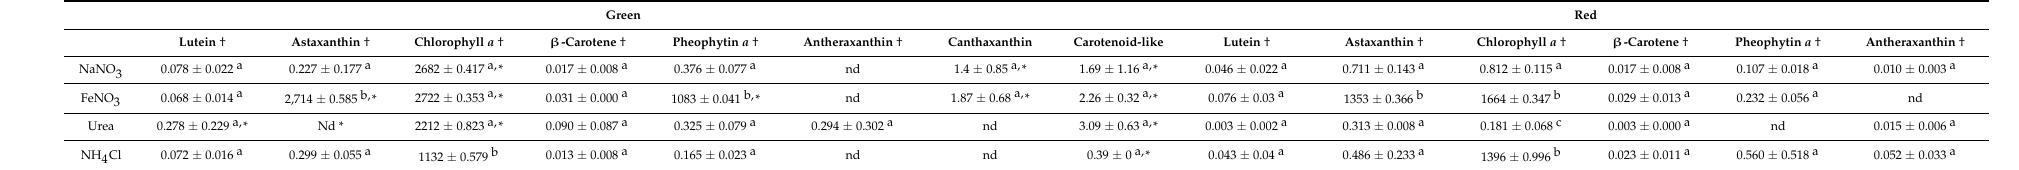
Table 1. Quantitative pigment composition (in mg/g DW), obtained by HPLC analysis, of H. pluvialis cells at the end of the green and red phases stationary phase, in cultures previously supplied with equimolar concentrations of nitrogen from different sources. Values are reported as the mean value ( n = 3) ± 1 S.D. The letters indicate significant differences in the concentration of individual pigments between biomass cultivated using different NS at either green or red phase ( p < 0.05), while the differences between the green and the red phase in each treatment are denoted by * ( p < 0.05). Pigments denoted with † have been quantified based upon the relative peak area of an internal standard (trans- β -Apo-8 (cid:48) -carotenal). Green